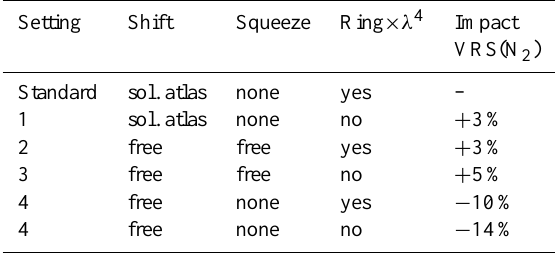
Table 7. Impact on the ratio of VRS(N 2 ) and RRS depending on different fit settings for the spectral retrieval, given in % relative to the standard settings, where the shift of the literature cross-section was determined from a fit using a convolved solar atlas. The mean RMS for all settings did not vary by more than 5% around the mean RMS of 7 . 5 × 10 − 5 for the standard